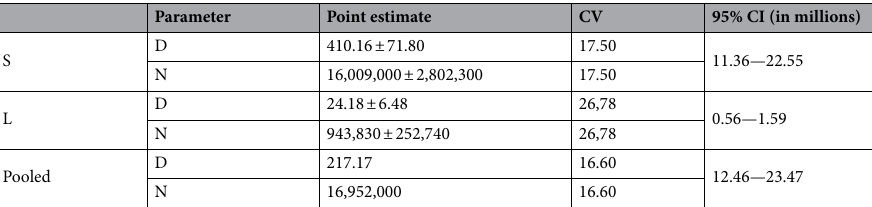
Table 1. Estimates of density (D: carcasses per km 2 ) and number of dead vertebrates (N), their standard errors, coefficient of variation (CV), and confidence interval (CI), by body size group and pooled data, where small-sized vertebrates (S): < 2 kg; medium-large sized vertebrates (L): 2 kg and over. Estimates were, obtained by analyzing distance sampling data in the area hit by wildfires in the Brazilian portion of the Pantanal wetland in